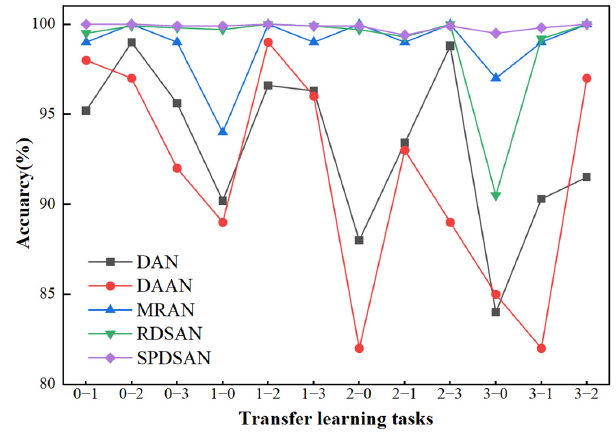
Figure 7. Diagnostic accuracy of the CWRU dataset.